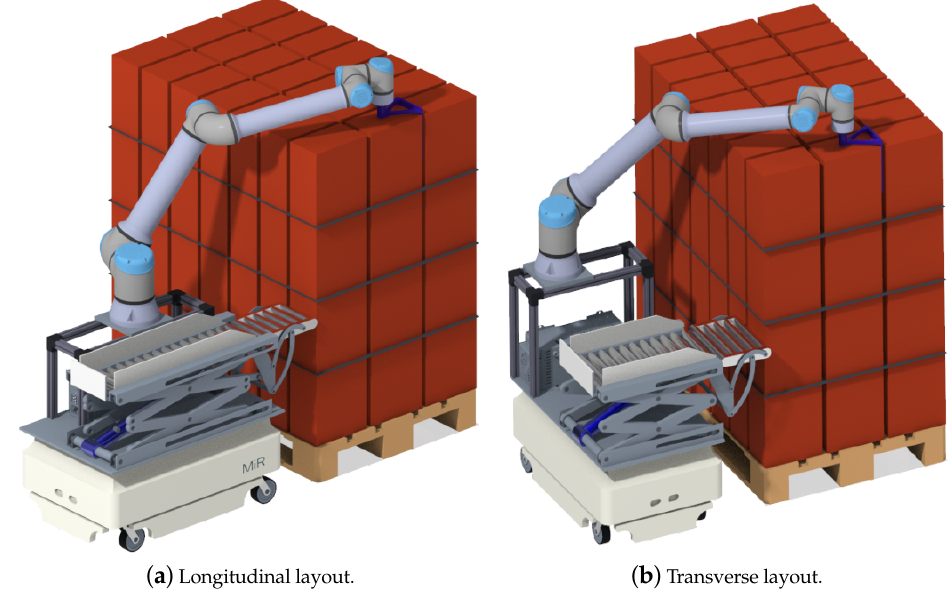
Figure 2. Comparison between transverse ( a ) and longitudinal ( b ) layout.